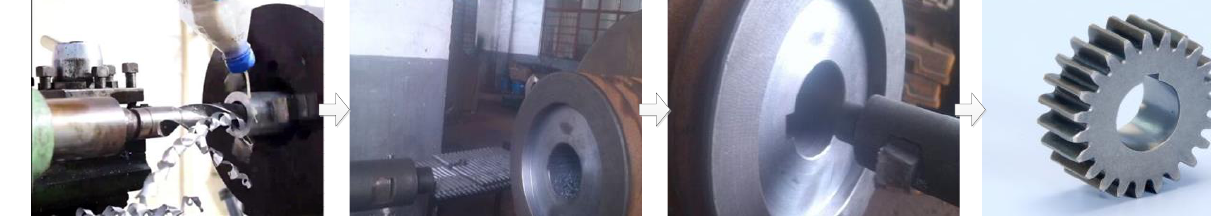
Figure 2. Stages of the gear during the manufacturing process.